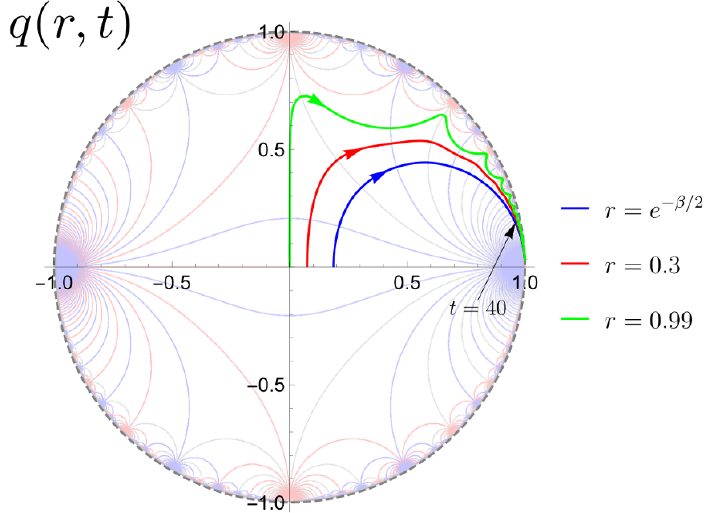
re (cid:0) it and plotted the (cid:0) . Note that 12 1, the coordinate z approaches an OPE (cid:25)